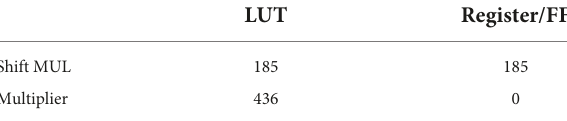
TABLE 4 Resource utilization of multipliers.